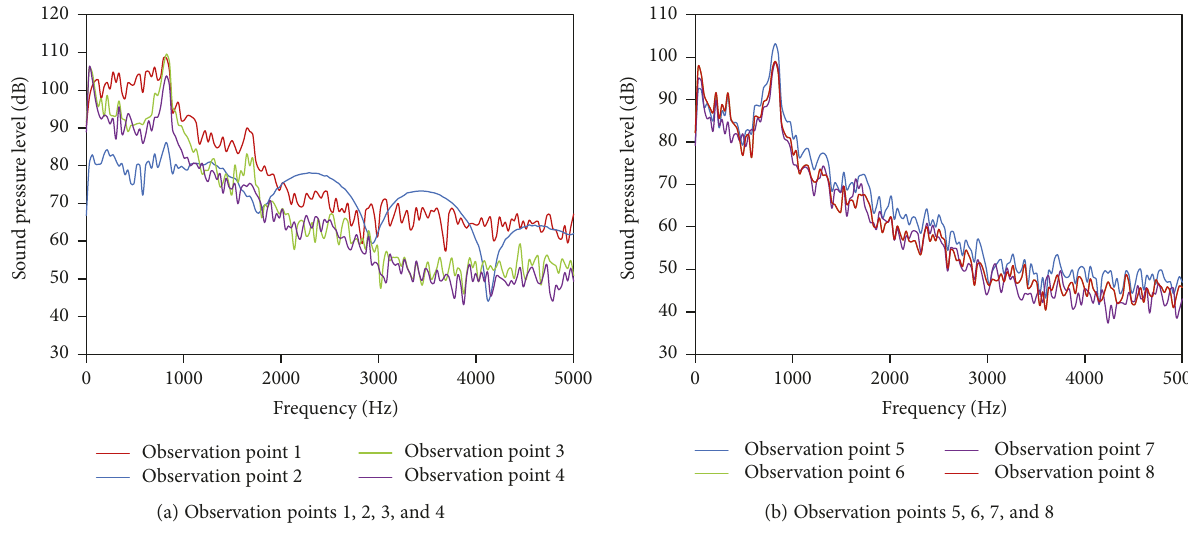
Figure 5: Sound pressure levels of observation points of asymmetric cross-section